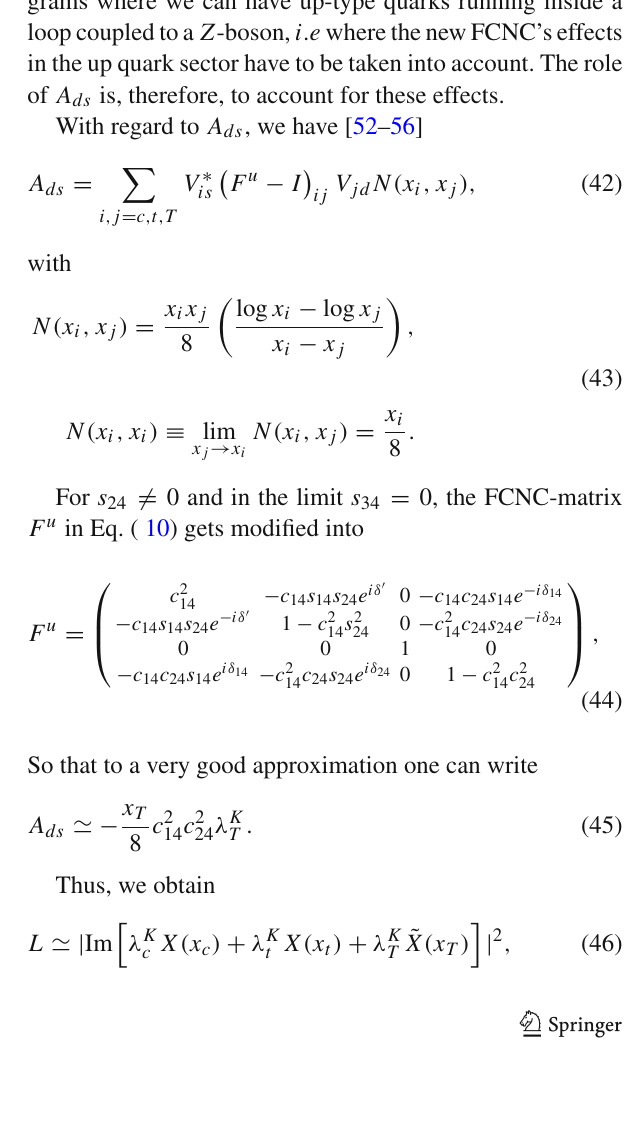
MeV, (cid:15) D = 1 /τ D with τ D = ( 410 . 1 ± 1 . 5 ) × 10 − 15 s [25], B D = 1 . 18 + 0 . 07 − [44] and f D = 212 . 0 ± 0 . 7 MeV [36]. 0 . 05 Requiring s 24 (cid:2) λ 5 yields an upper bound for the NP contri- < 0 . 015%,whichisnegligiblewhencompared butionof x NP D = 0 . 39 + 0 . 11 to the experimental value, x exp − 0 . 12 % D